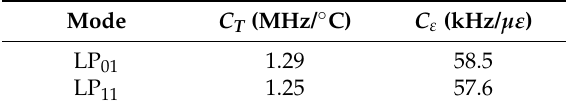
Figure 14. Signal-to-noise ratio (SNR) comparison for FM-BOTDR system between LP 01 and LP 11 mode along the sensing fiber. Table 1. Comparison of f -T and f - ε coefficients in